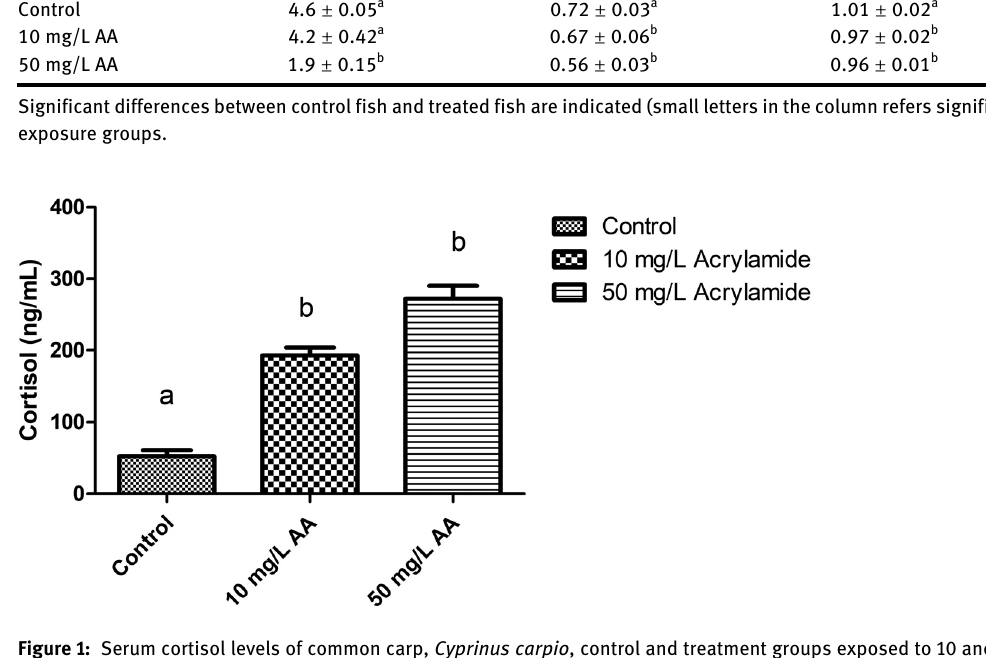
Figure 1: Serum cortisol levels of common carp, Cyprinus carpio , control and treatment groups exposed to 10 and 50 mg/L acrylamide. Signi fi cant differences between control fi sh and treated fi sh are indicated (a, b p<0.05) for each exposure